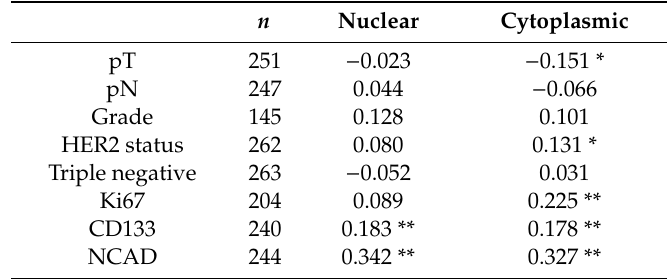
Table 4. Correlation between THR β 1 expression and clinicopathological markers. HER2, human epidermal growth factor receptor 2; NCAD, N-cadherin. n Nuclear Cytoplasmic pT 251 − 0.023 − 0.151 * pN 247 0.044 − 0.066 Grade 145 0.128 0.101 HER2 status 262 0.080 0.131 * Triple negative 263 − 0.052 0.031 Ki67 204 0.089 0.225 ** CD133 240 0.183 ** 0.178 ** NCAD 244 0.342 ** 0.327